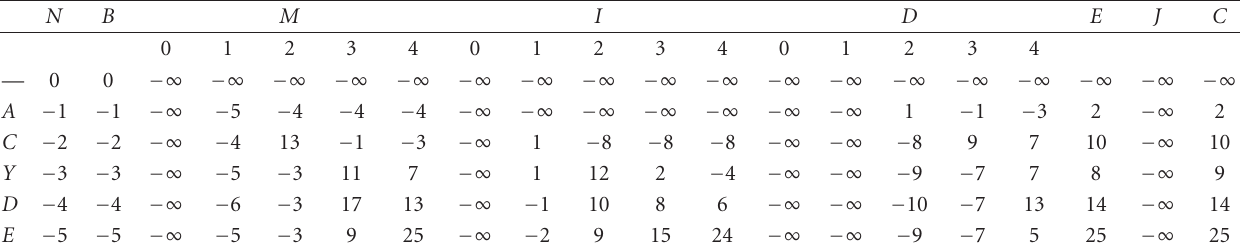
Table 2: Score matrices and vectors of the Viterbi algorithm for the comparison of the sequence ACYDE against the profile HMM of Figure